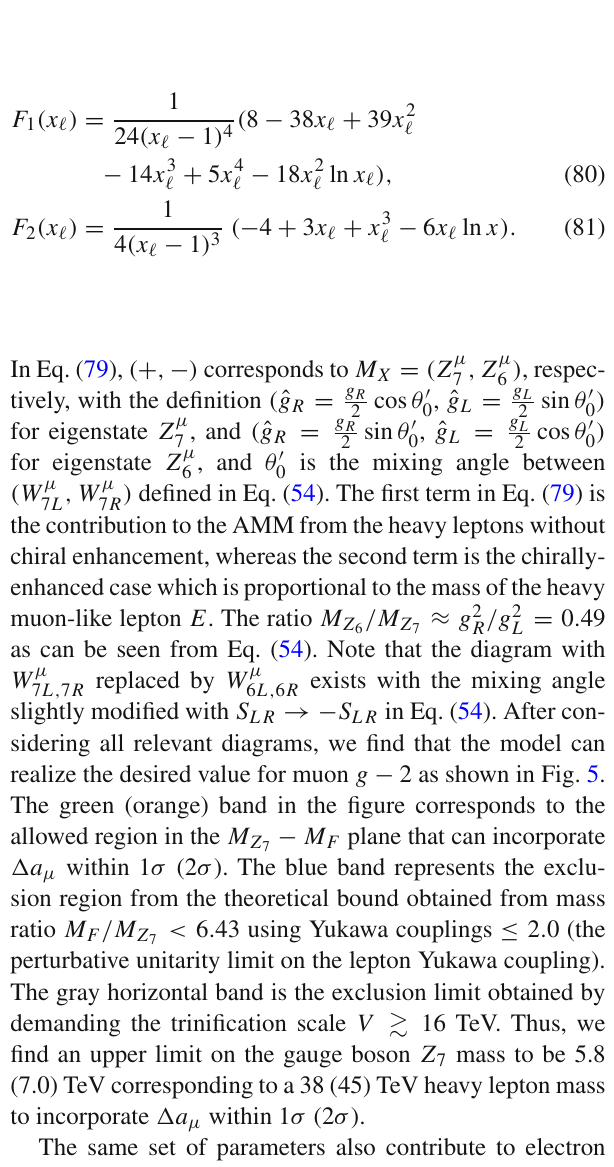
Fig. 4 A typical one-loop contribution from gauge bosons to the muon anomalous magnetic moment